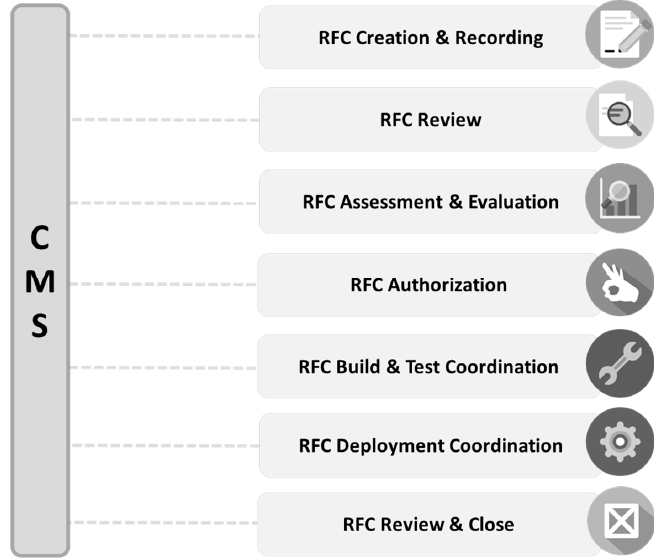
Figure 3. Change management process adapted from Information Technology Infrastructure Library